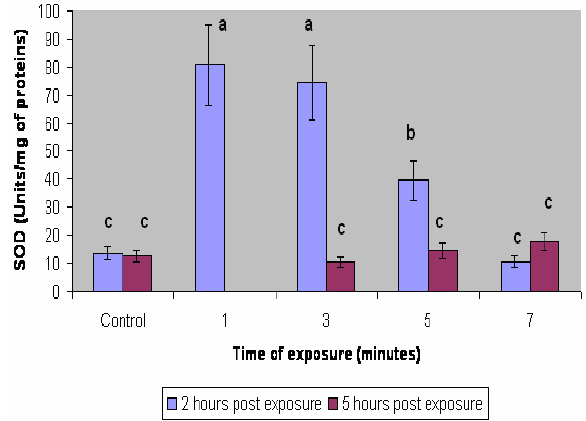
Figure 3: Effect of UV-B radiation on superoxide dismutase activity in Bufo arenarum embryos